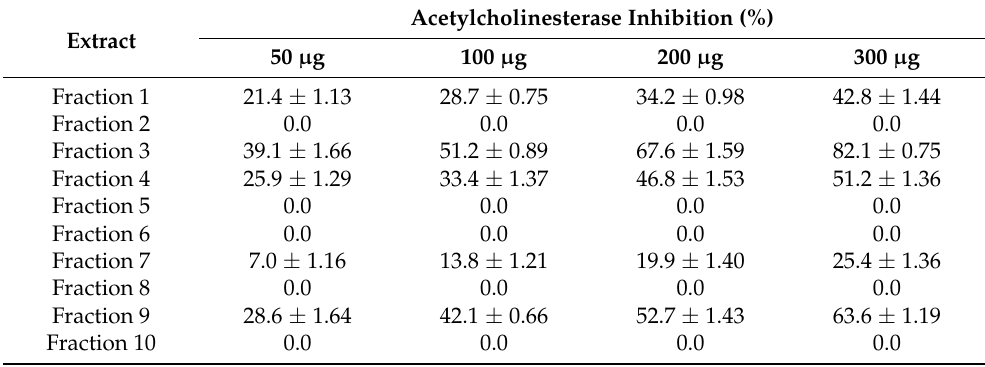
Table 2. Acetylcholinesterase inhibition (%) of different fractions separated from SB5. Extract